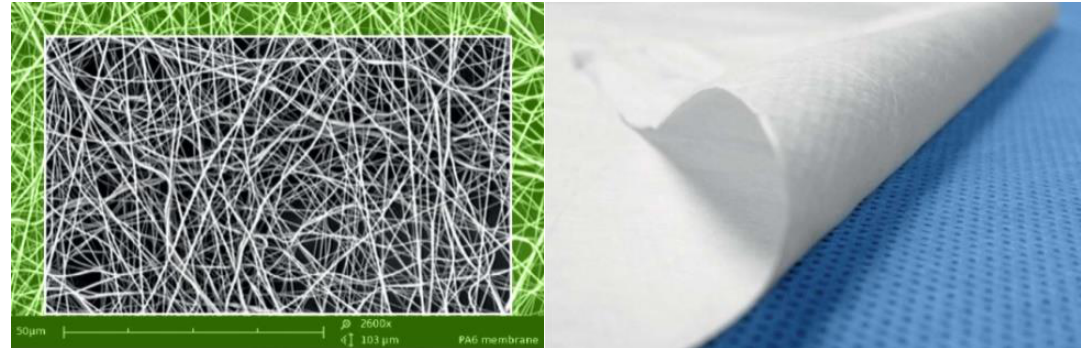
Figure 2. SEM image of PA-6 (nylon 6) nanofibers magnification 2600× ( left ), and PA-6 nanomembrane on PP spunbond support ( right ).